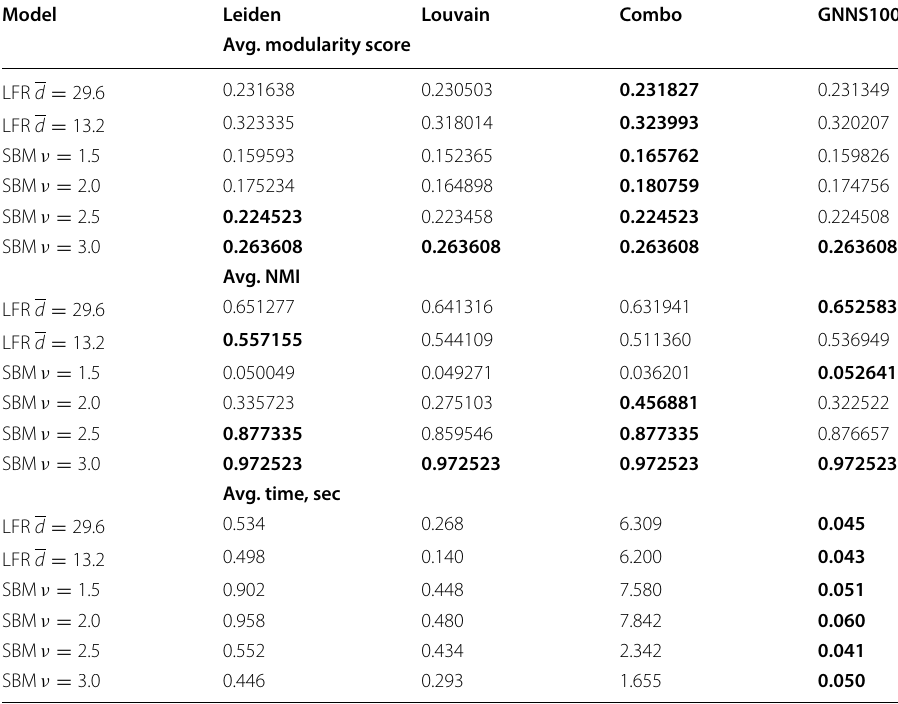
The best results are in bold